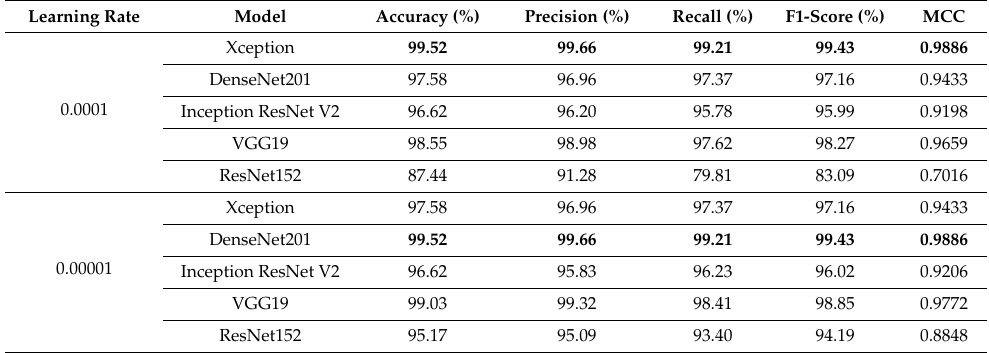
Table 6. Results of 100 × magnification factor in binary classification mode; the highest results are shown in